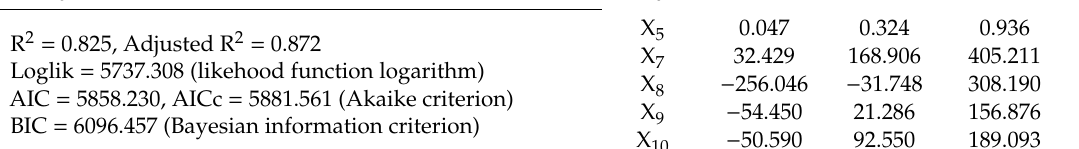
Table 6. Results of the MGWR1 (mixed geographically weighted regression) model parameter estimation.